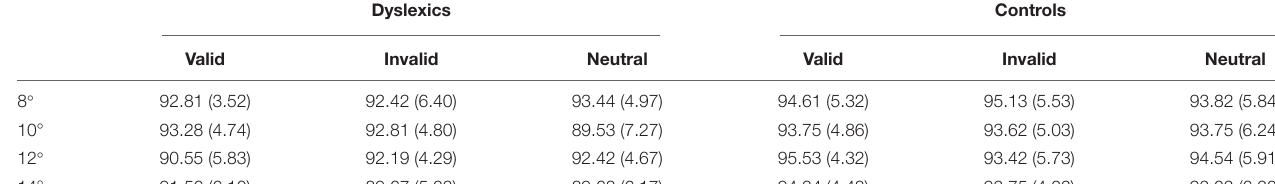
TABLE 2 | Means and standard deviation (in brackets) of the hit rates (percentage) of dyslexics and controls at the four viewing eccentricities (8 ◦ , 10 ◦ , 12 ◦ , and 14 ◦ ) and for the three cue types (valid, invalid, and neutral).